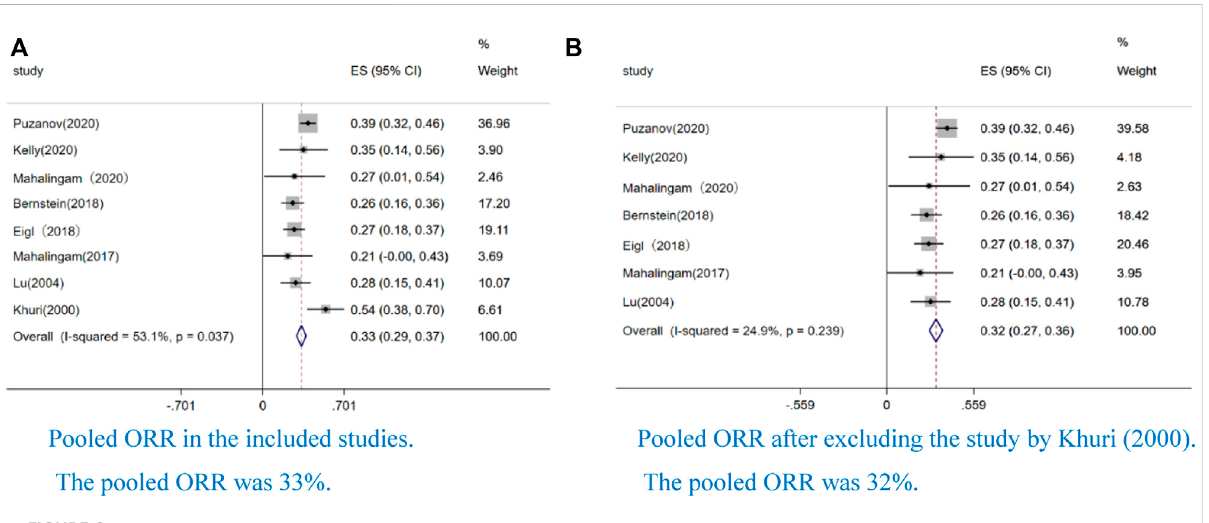
FIGURE 2 Forest plot of the pooled rate of objective response (ORR) to OVs combined with chemotherapy or ICIs. Eight studies reported ORR. We performed a sensitivity analysis because we found that the pooled ORR has signi fi cant heterogeneity (I2=53.1%, p=0.037) (Figure 2). After excluding thestudybyKhurietal,we fi nallyobtainedapooledORRof32%(CI:27 – 36%,I2=24.9%,p=0.239)(Figure2).Intheallforestplotsthatwepresented, the square represents effect sizes from a single study and the side represent weight; the diamond represents the pooled result of single study; thereddottedlinerepresentsthemeanofthepooleddata;thehorizontallinerepresentsasinglestudy;thehorizontallinelengthrepresentsthe95% con fi dence interval (CI) of the effect size of a single study; thesolid line perpendicular to the X-axis represents the null line and the coordinate of the effect value is 0 (continuous variable); I 2 > 50% indicated that the pooled data was highly heterogeneous; weight represent the proportion of single